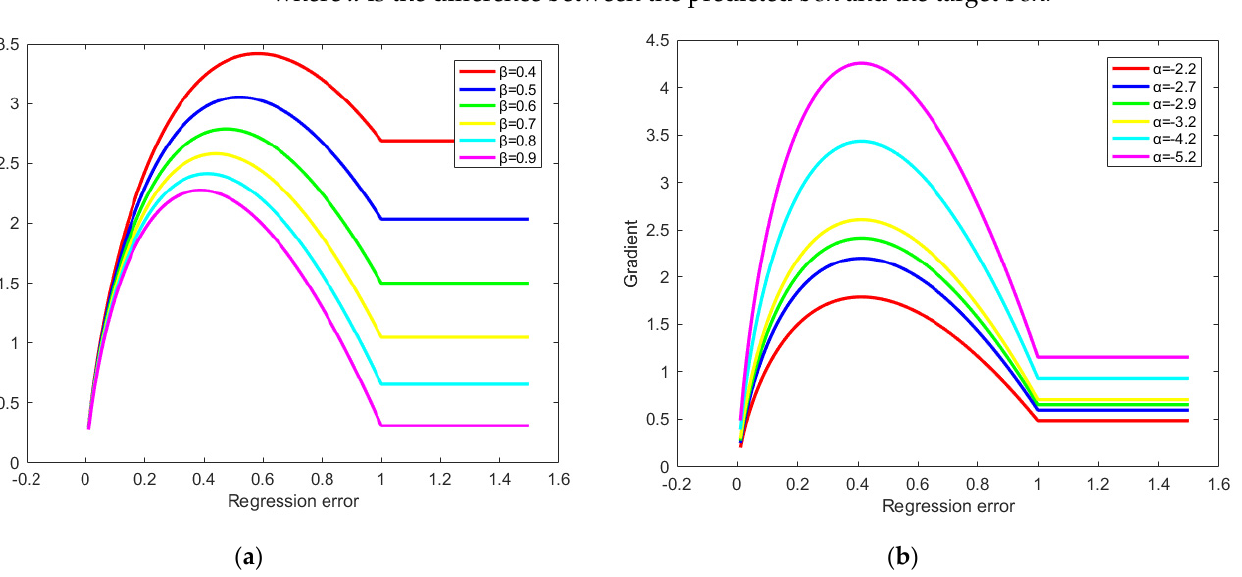
Figure 5. Possible gradient curves: ( a ) use β to control curve shape; ( b ) use α to control curve shape.